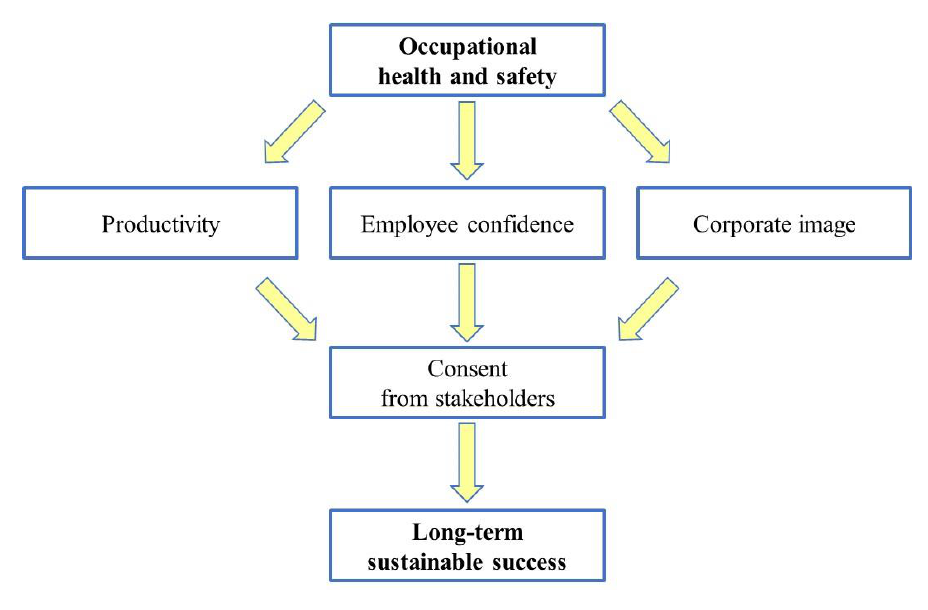
Figure 1: Impact of Occupational Health and Safety on Corporate